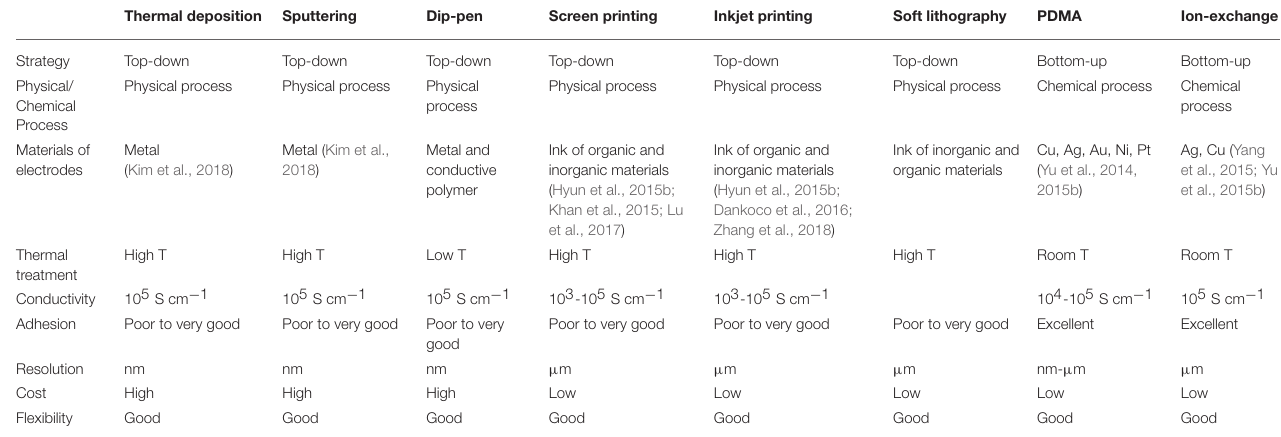
TABLE 1 | Technical specifications of flexible electrode technologies. Thermal deposition Sputtering